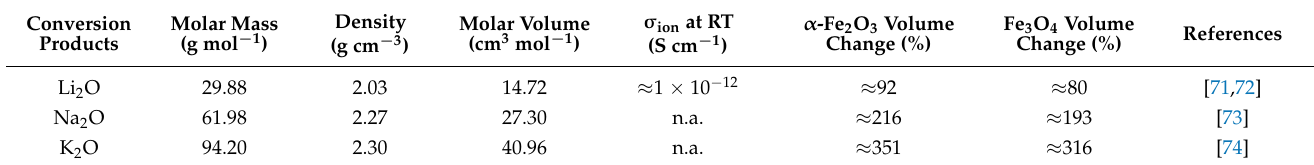
Table 3. Comparison of some physical properties of alkali oxides arising from conversion of iron oxides upon respective lithiation, sodiation and potassiation along with associated theoretical volume changes from their pristine state to their fully reacted and converted states.